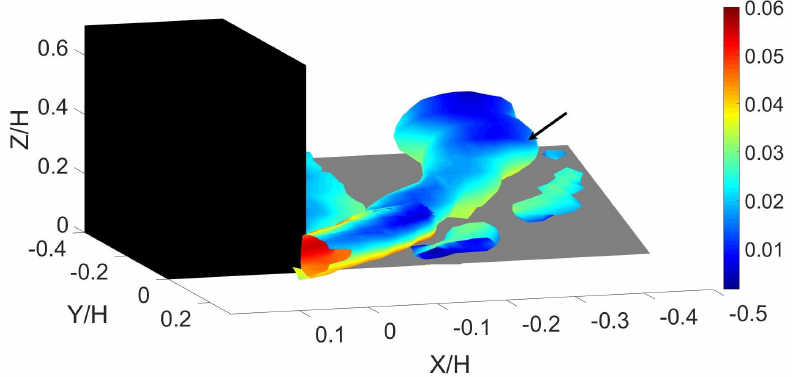
Figure 21. The first energetic POD mode. The color coding represents the Euclidean norm of the (cid:113) φ u 2 + φ v 2 + φ w 2 . Note that φ u , φ v and φ w are the POD sub-modes modes calculated as | φ | 2 = associated with the streamwise, lateral, and vertical velocities,